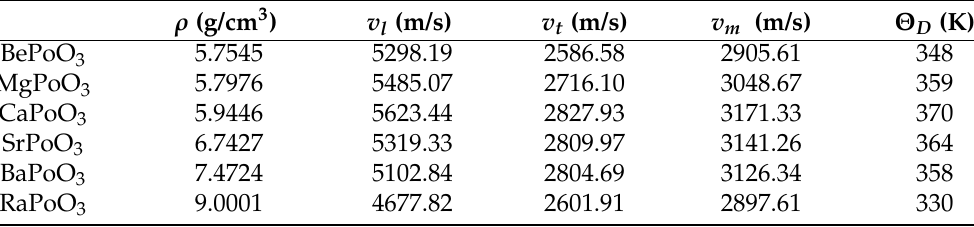
Table 3. Calculated density ρ (g/cm 3 ), the longitudinal, v l (m/s), transverse, v t (m/s), average sound velocity, v m (m/s), and Debye temperature Θ D (K) from the elastic moduli. ρ (g/cm 3 ) v l (m/s) v t (m/s) v m (m/s) Θ D (K) BePoO